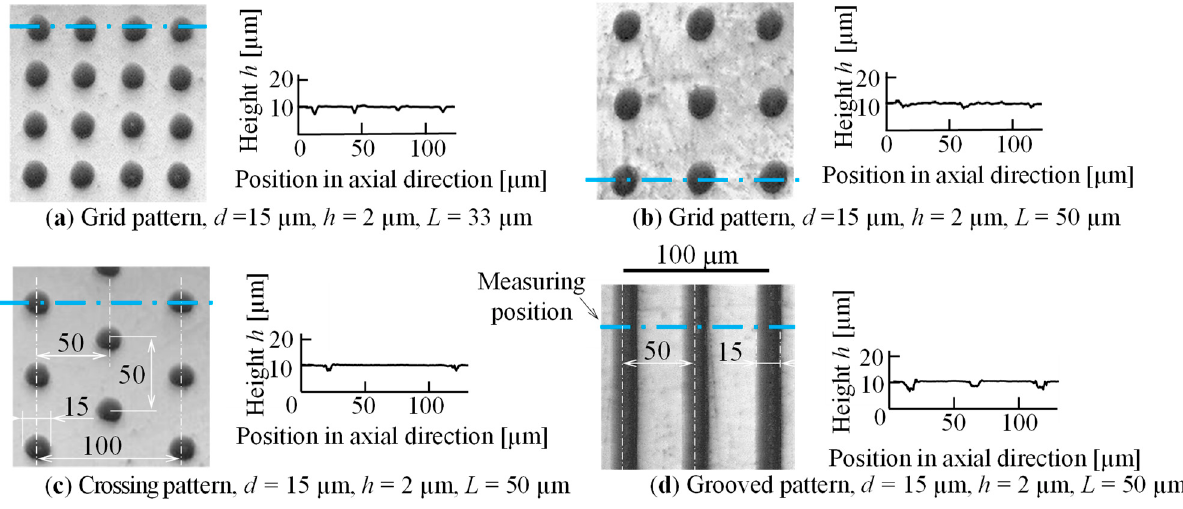
Figure 2. Micrographs and 2D profiles of array patterns of micro-lubricant pockets: grid array pattern having d = 15 µ m, h = 2 µ m ( a ) L = 33 µ m and ( b ) L = 50 µ m; ( c ) crossing array pattern having d = 15 µ m, h = 2 µ m, L = 50 µ m; ( d ) grooved array pattern having d = 15 µ m, h = 2 µ m, L = 50 µ m.